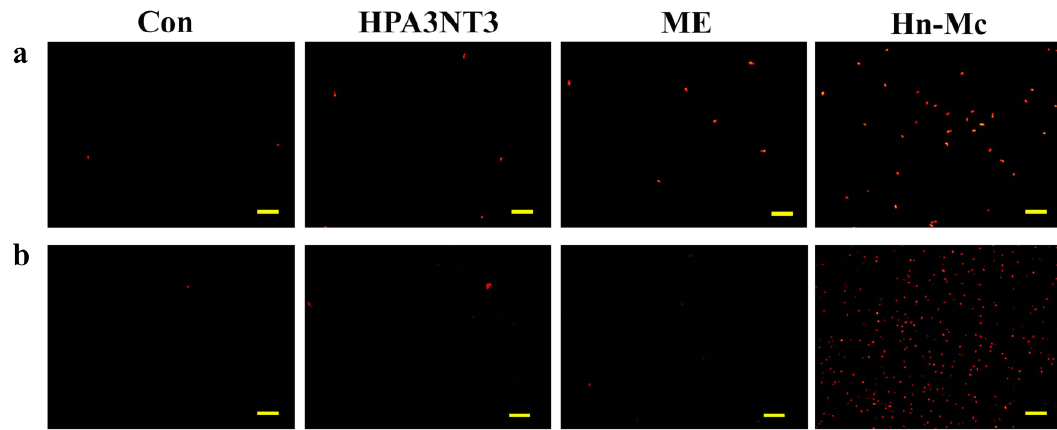
Figure 5. Mitochondrial superoxide (MitoSOX) generation upon treatment of peptides with C. tropicalis ( a ) and F. oxysporum ( b ). Fungal cells w ere incubated with 8 μM of HPA3NT3, ME, and Hn-Mc for 2 h, stained with MitoSOX Red, and analyzed using a fluorescence microscope. Scale bars, 10 μm.